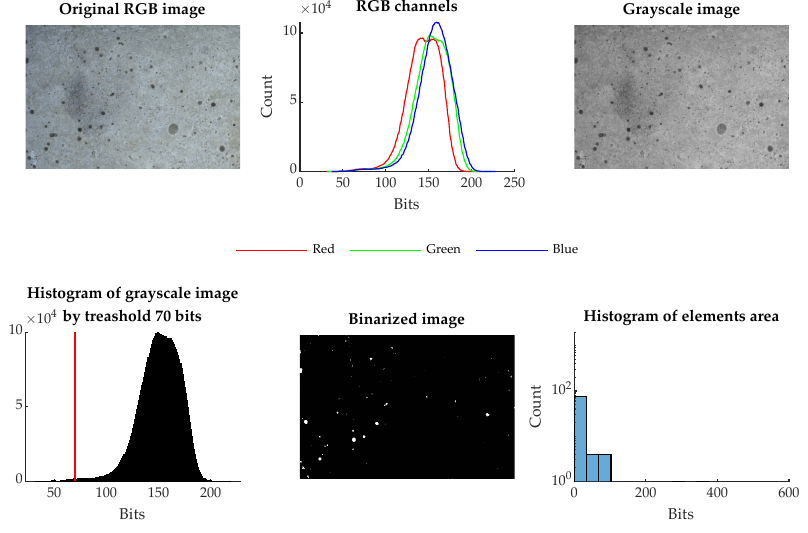
Figure 13. The process of image feature BW ratio I R for specimen degraded at 20 °C. The effect of using the parameters from the image analysis of the surface photographs of the thermally degraded concrete bodies can be seen in the distinction between the set degraded to 20 and 1200 °C, as documented by the correlation diagram in Figure 15. Here, the selected main parameters extracted from the photos, namely the average value of the blue channel, the skewness of the image bits in grayscale, the photo energy, and the ratio between the number of white and black pixels from the binary image, are compared in the correlation. This comparison shows the separation of the test set degraded at 1200, 1000 and 800 °C. This separation is most evident when comparing the blue channel with virtually all other parameters. This separation is most evident in the comparison of the image energy and the ratio of white to dark pixels. The remaining 20–600 °C test sets are already mixed in most cases in one cloud of measured points.